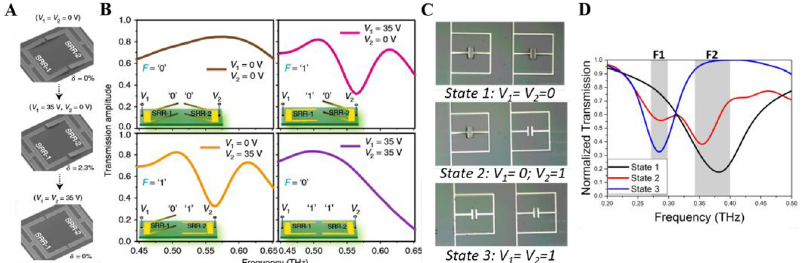
Figure9: (A)SEMimageoftheunitcellwhere two SRRs are at different input states. (B) The Fano resonance output shows the behaviors of exclusive-OR (XOR) logic operation. The inset is the corresponding electric input [127]. (C) OM image of the ESRRs at three different input states (D) Measured transmission spectra at three states,withNORatF1(0.26THz)andANDat F2 (0.36 THz)